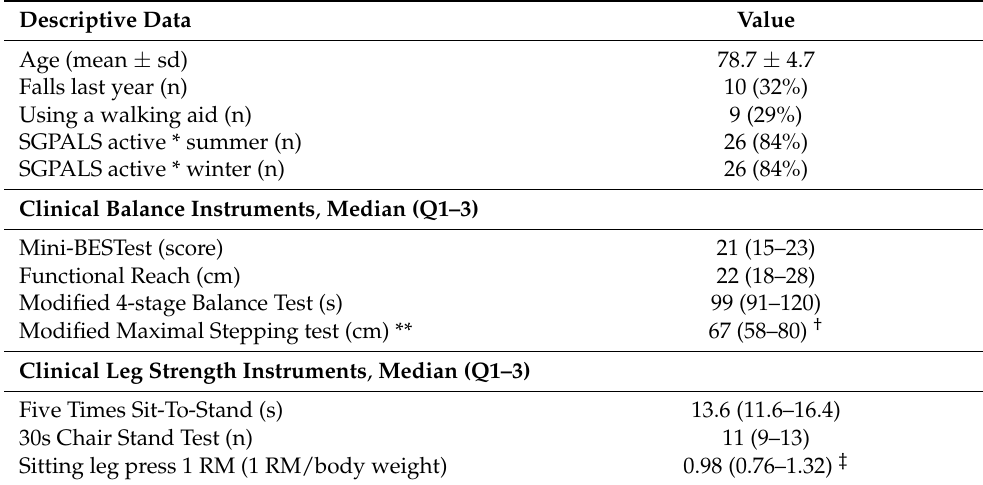
Table 2. Descriptive data and measurements from clinical instruments (n =